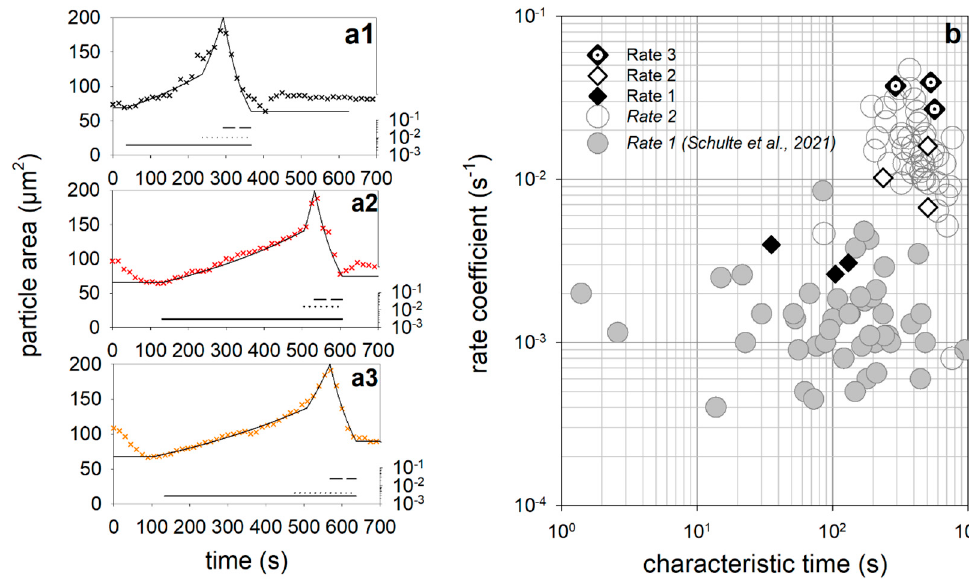
Figure 3. ( a1 − a3 ): Individual analysis of the three swelling peaks from Figure 2 with the extended sequential swelling model. ( b ) Plot of the simulated values for rate coefficient and characteristic time of the three process steps, in comparison with data from previous measurements [23].